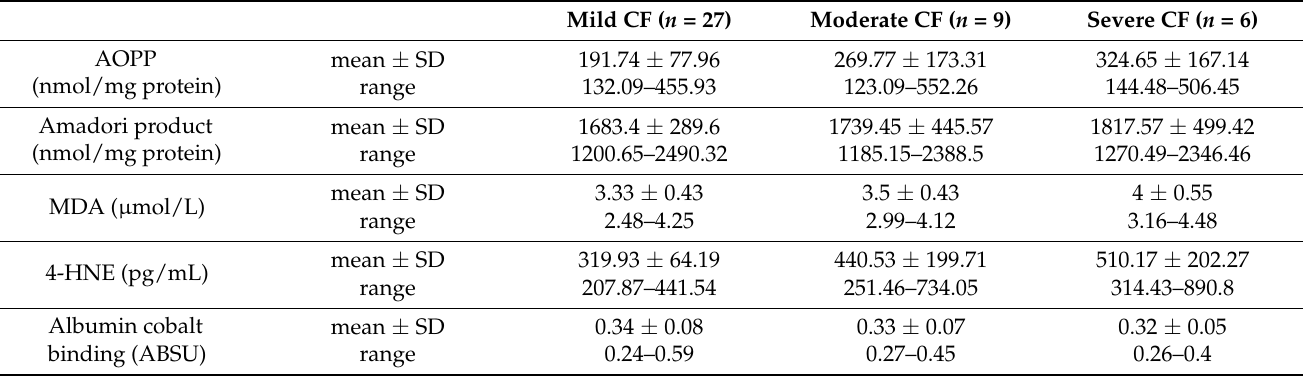
Table 3. Markers of oxidative stress in participants with CF depending on severity of illness a